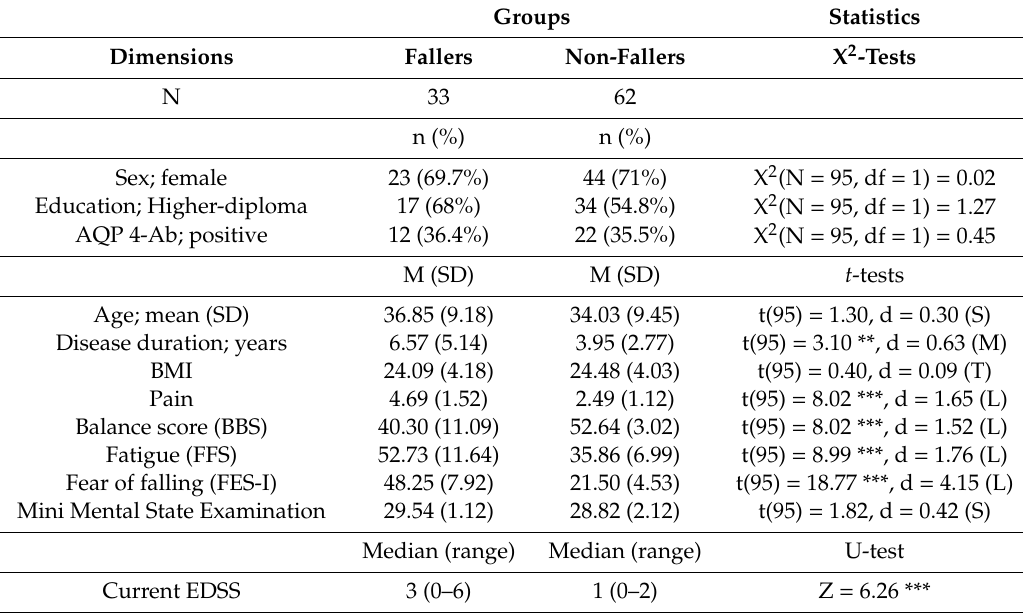
Table 3. Descriptive and statistical comparisons of sociodemographic and illness-related information between individuals with neuromyelitis optica spectrum disorder (NMOSD) labelled as fallers and